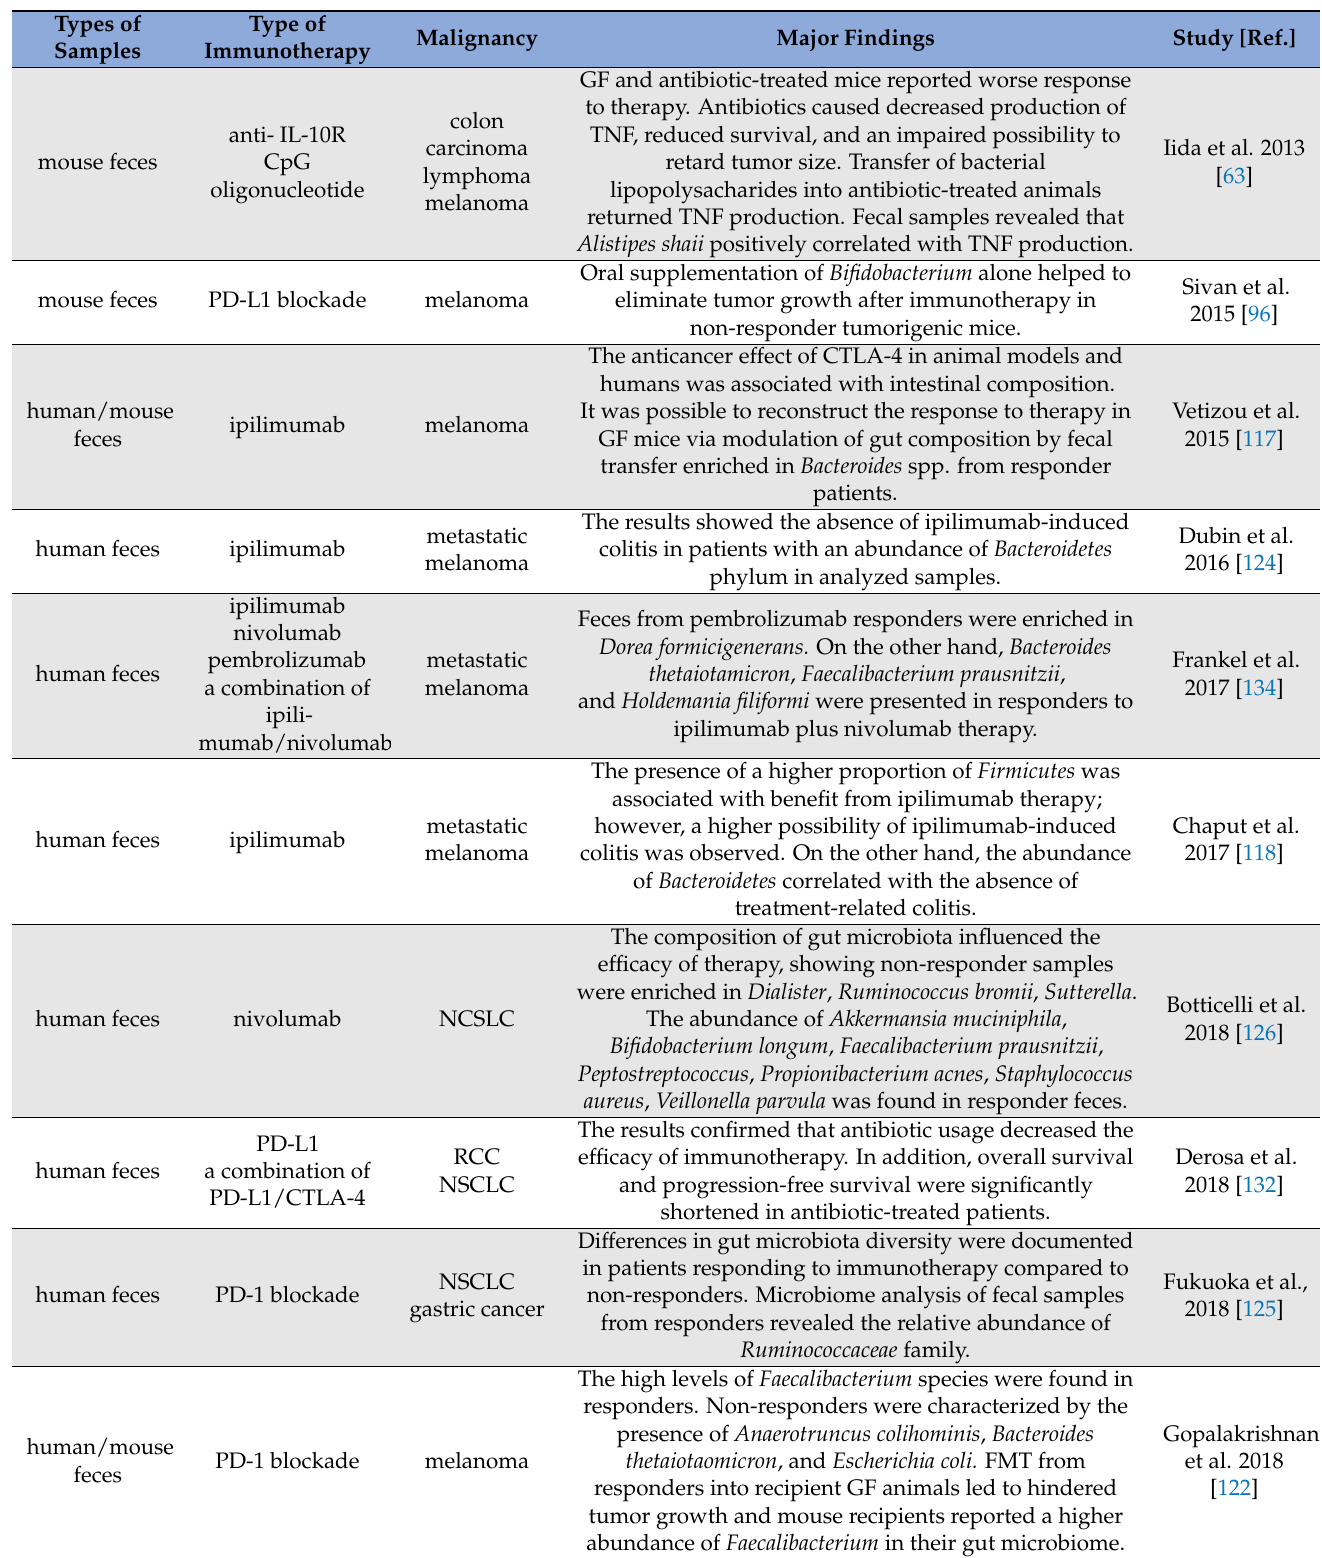
Table 2. The emerging role of the gut microbiome in efficacy of immunotherapy. The table summarizes the major findings from preclinical and clinical